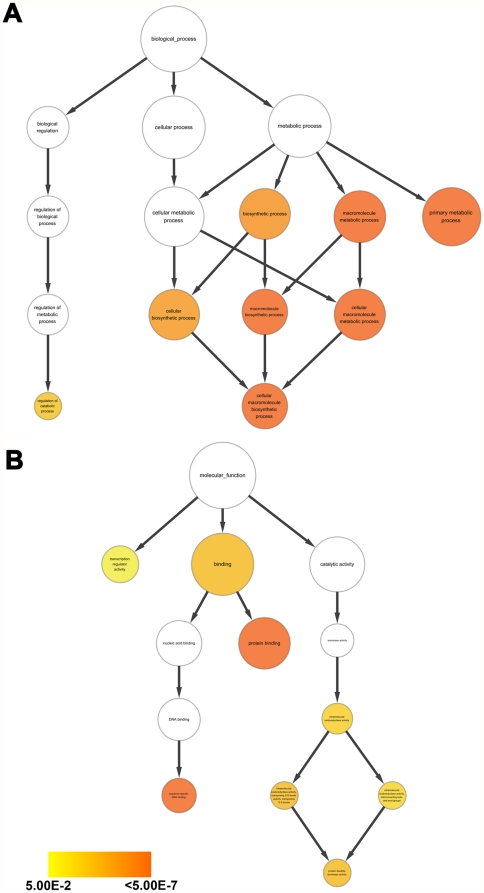
GO analyses of the top 153 identified proteins.GO provides each defined term representing gene product properties. Herein, we showed 2 domains in the figure: A. Biological process, B. Molecular function. A p-value cut-off of 0.05 is used for analyses. The size of the term symbolizes the total gene membership; the size increases with an increasing number of genes. The color depth of each term illustrates the degree of enrichment; the color increases with a decreasing p-value. These identified proteins in the chip assays are primarily associated with cellular macromolecular metabolic processes, macromolecular metabolic processes and primary metabolic processes.